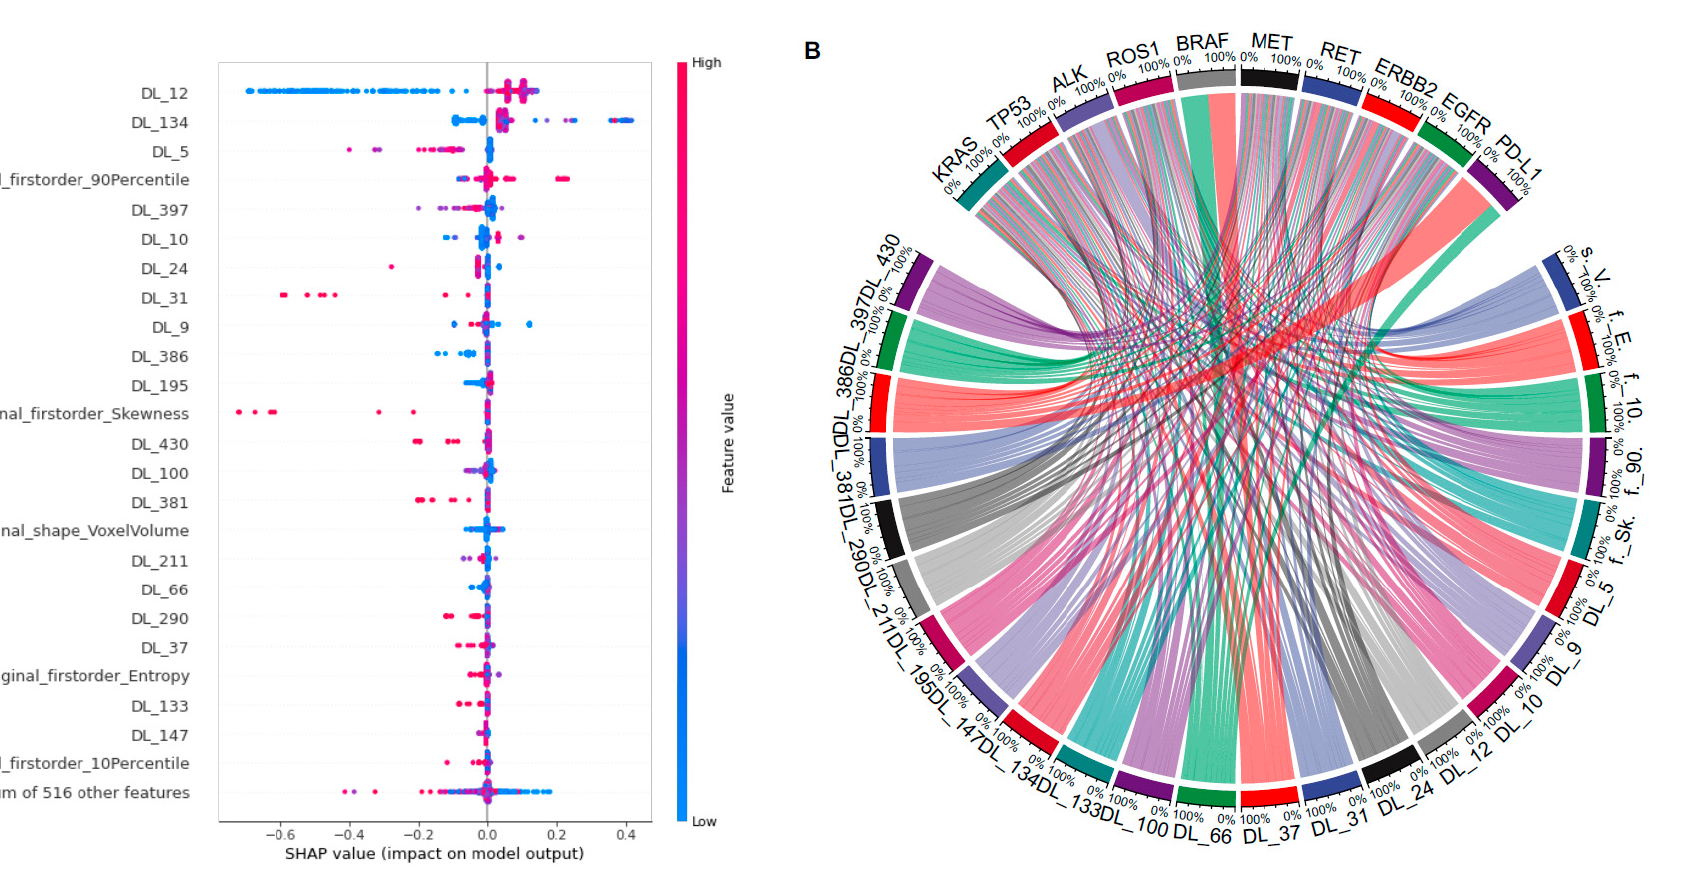
Figure 5. Visualization of the identified radiomics and deep learning features. ( A ) Multivariable logistic regression to identify radiomics and deep learning features associated with NSCLC patients. Abbreviations: DL, deep learning. ( B ) The correlations between selected features and ten molecules. The width of the link indicated the relative strength.